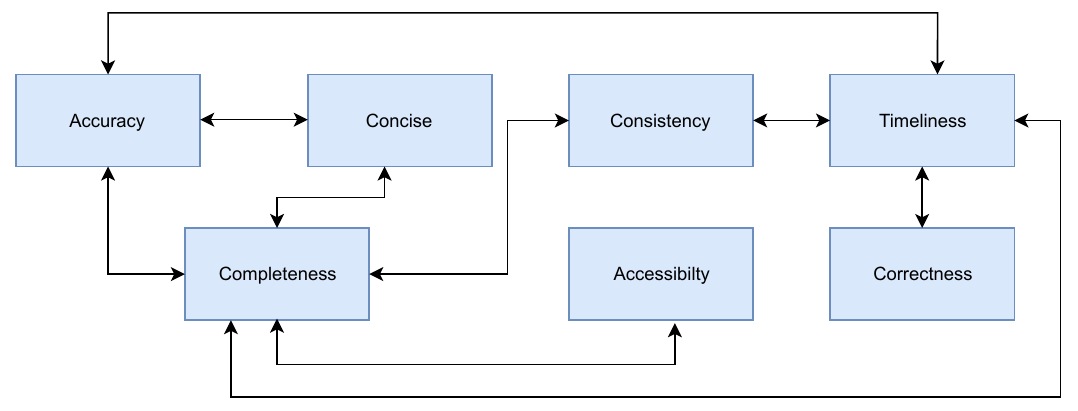
Figure 3. Trade-off between